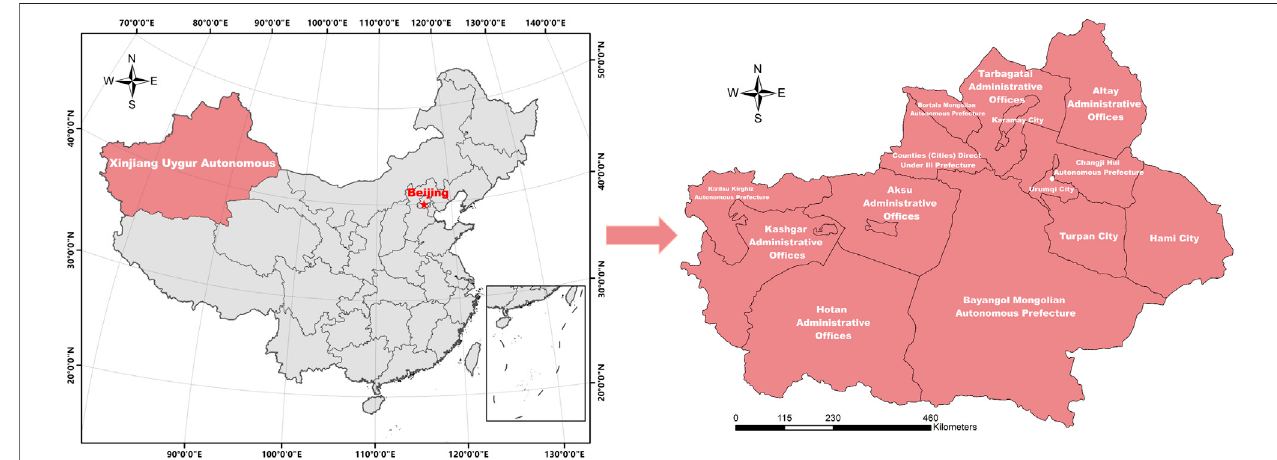
FIGURE 1 | Map of China and studied areas.